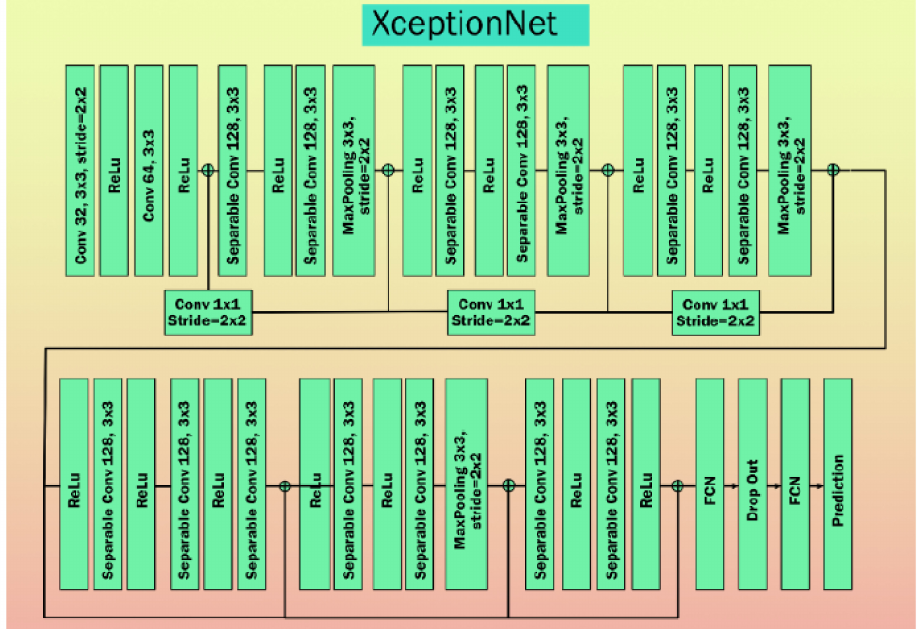
Figure A4. The general structure of XceptionNet architecture [292].